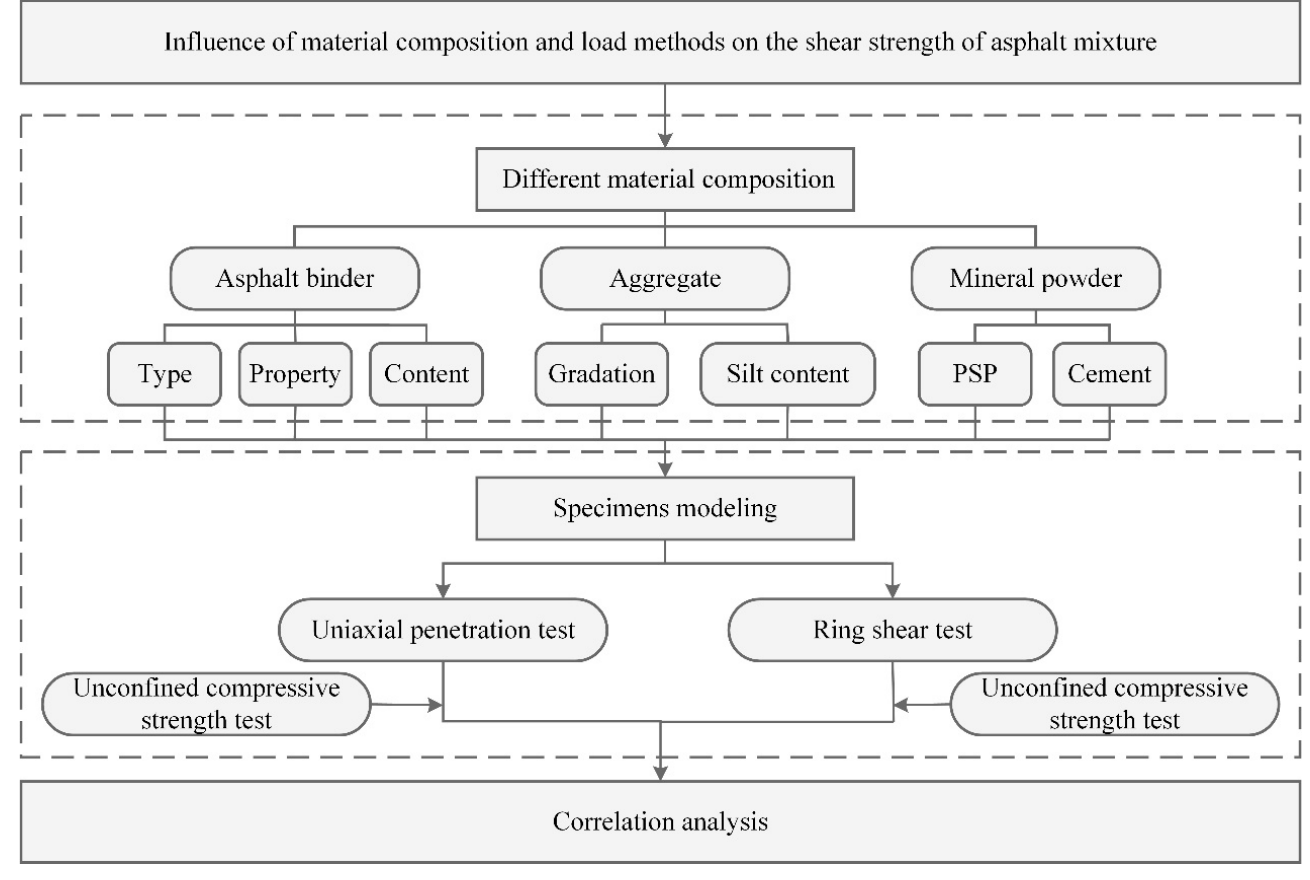
Figure 1. Research plan.